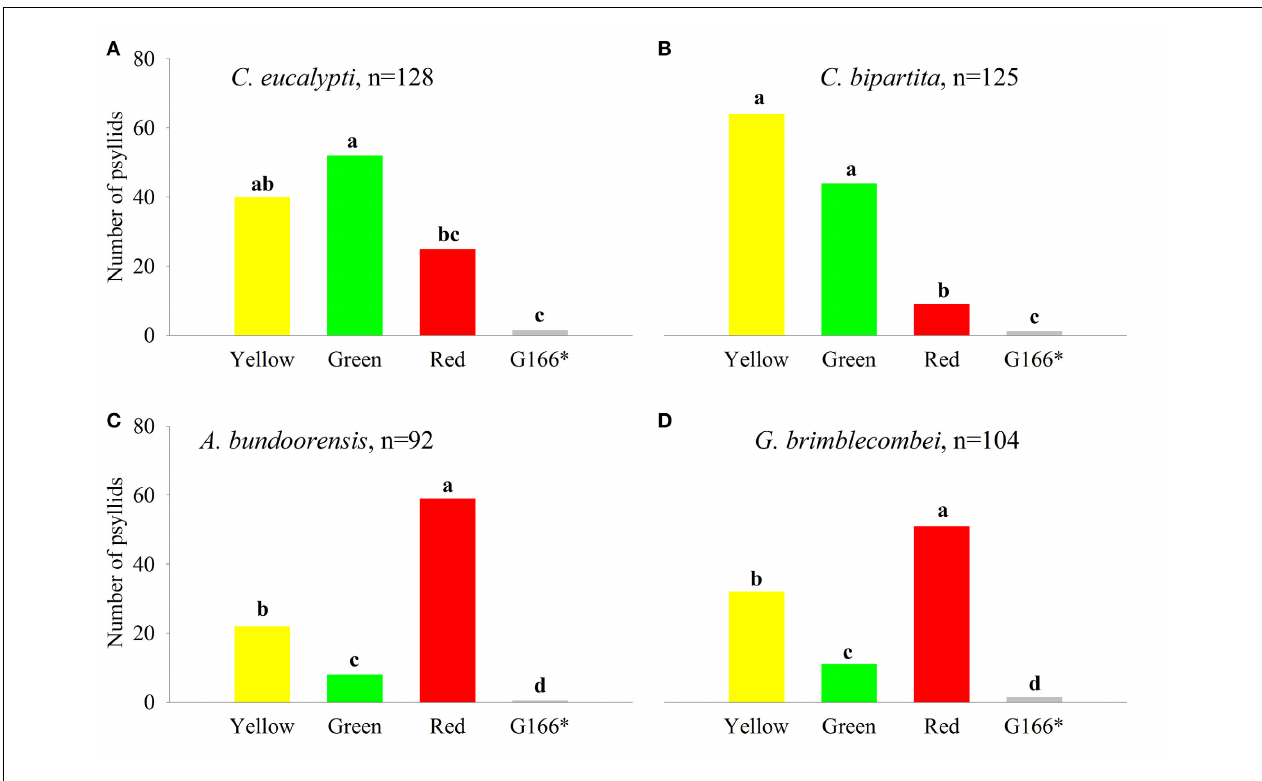
FIGURE 4 | Psyllid responses to color stimuli. (A) C. eucalypti , (B) C. bipartita , (C) A. bundoorensis and (D) G. brimblecombei . n represents the sample size for each species. Letters above the bars, group color stimuli